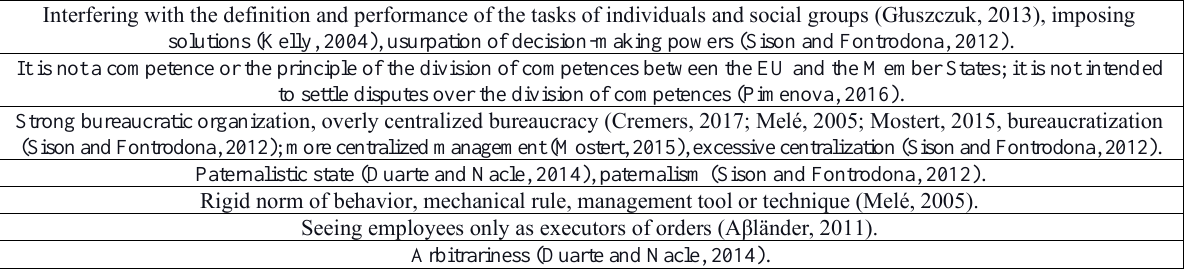
Table.2. Functional Attributes Opposed to the Principle of Subsidiarity Interfering with the definition and performance of the tasks of individuals and social groups (Głuszczuk, 2013), imposing solutions (Kelly, 2004), usurpation of decision-making powers (Sison and Fontrodona, 2012). It is not a competence or the principle of the division of competences between the EU and the Member States; it is not intended to settle disputes over the division of competences (Pimenova,